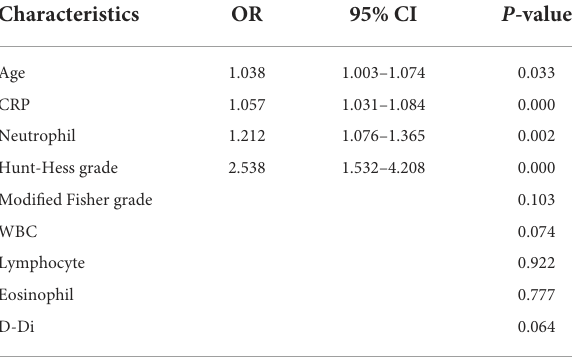
TABLE 4 Multivariable logistic analysis (Based on good prognosis group, poor prognosis group). Characteristics